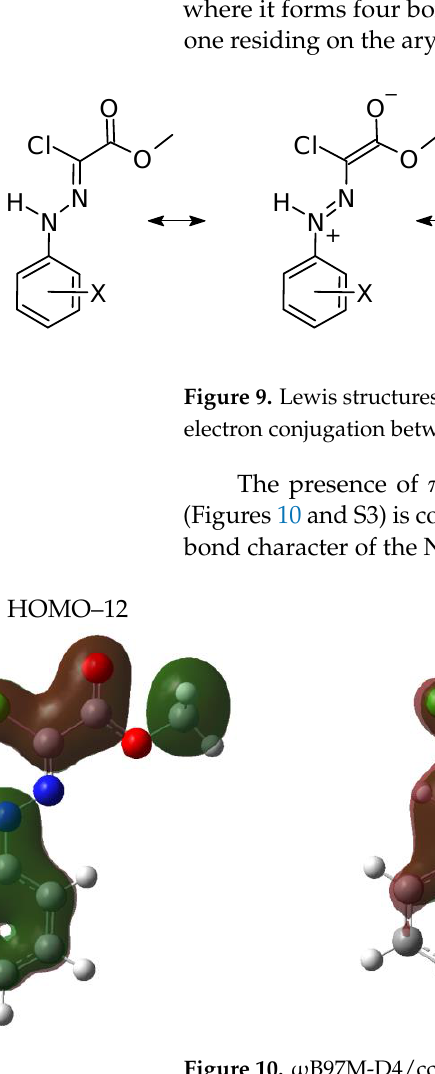
Figure 10. ω B97M-D4/cc-pVTZ MOs showing molecule-wide π delocalization in 1 -Zts.